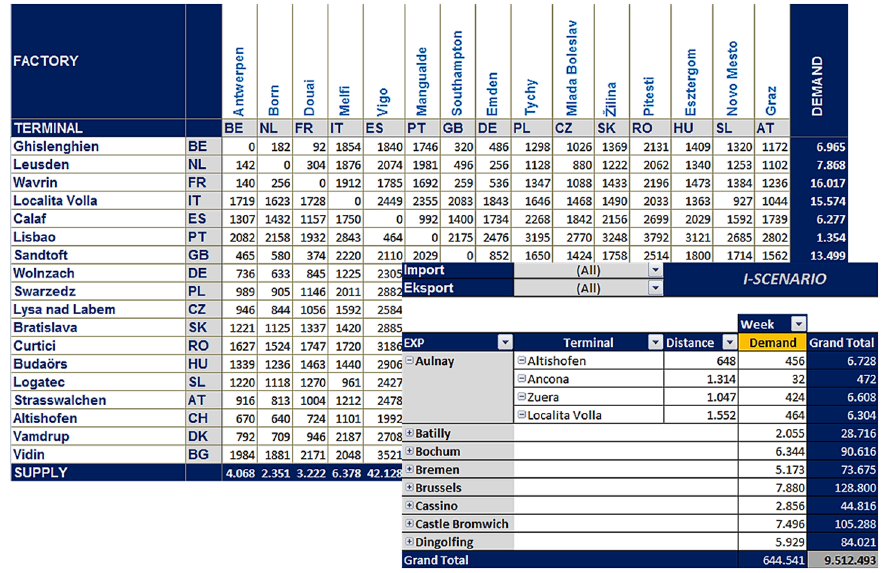
Fig. 3. A fragment of calculations by road transport